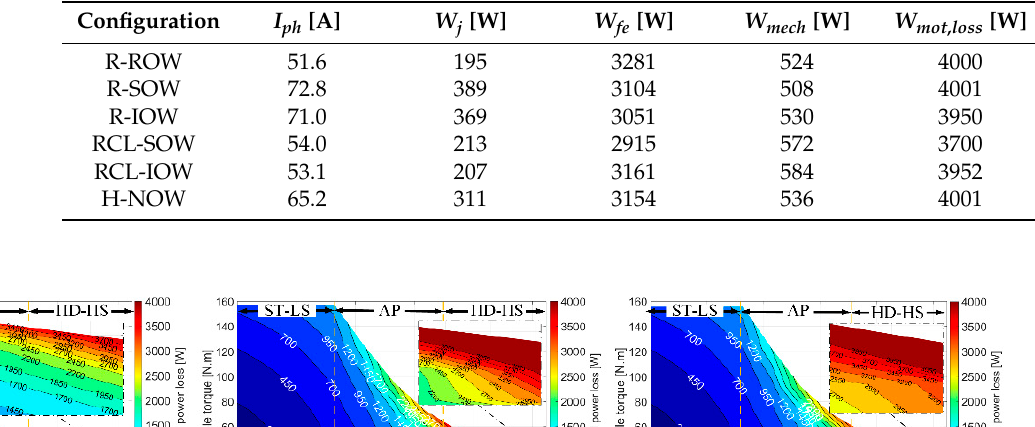
Table 4. Phase current and losses at the maximum speed, under flux weakening conditions, for the considered arrangements.